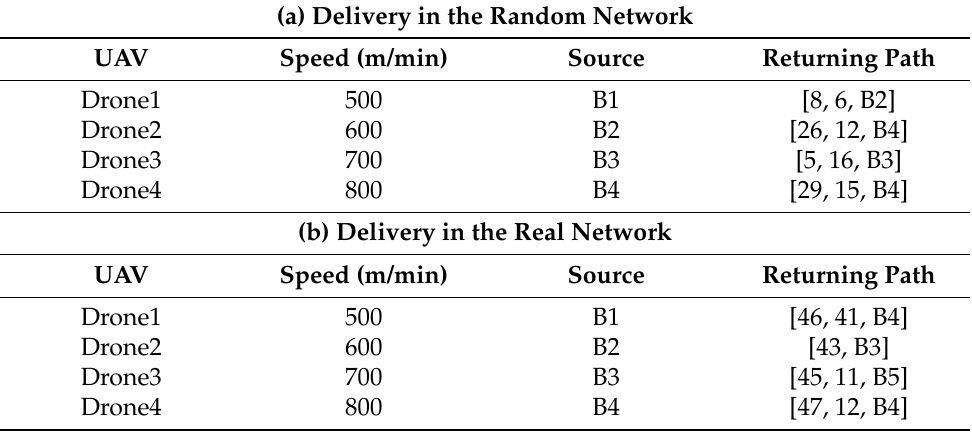
Table 4. Data delivery when speed distribution changes.